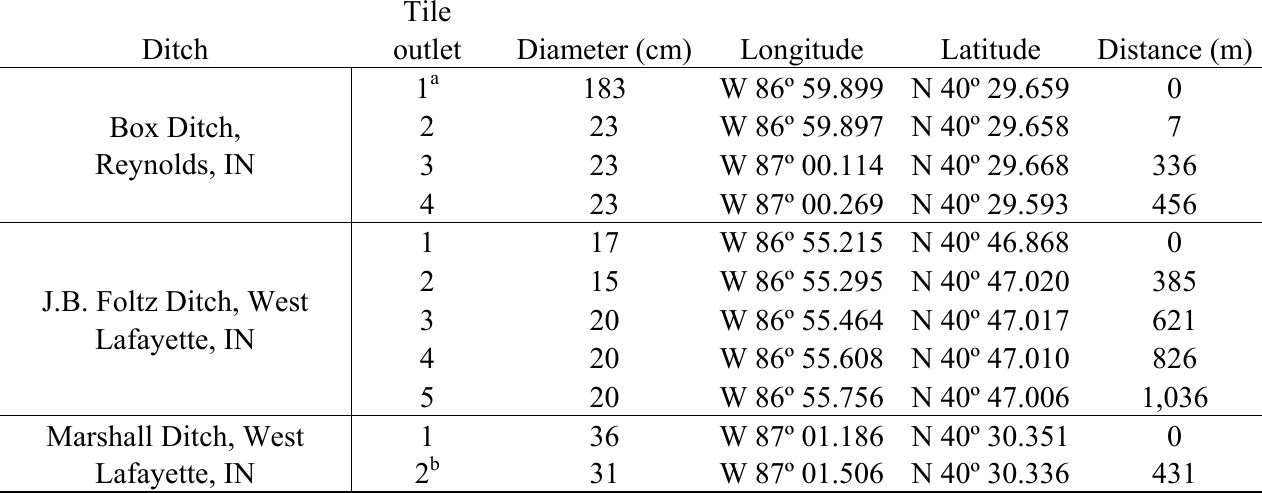
Table 1. Drainage ditches showing global positioning system coordinates of selected drain tile outlets and respective distances from the most upstream tile outlet within each